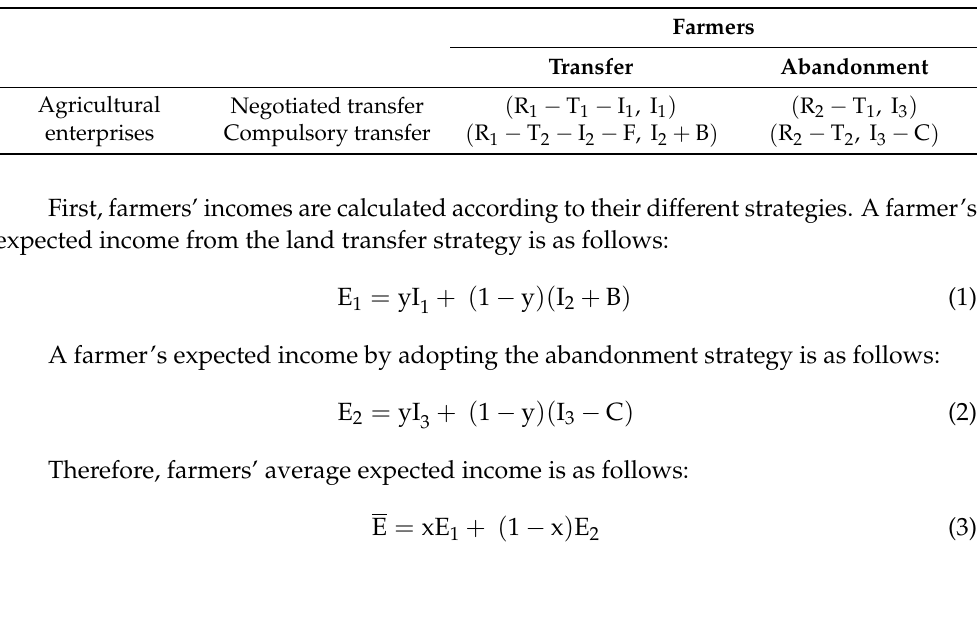
Table 1. Payment matrix of the game between farmers and agricultural